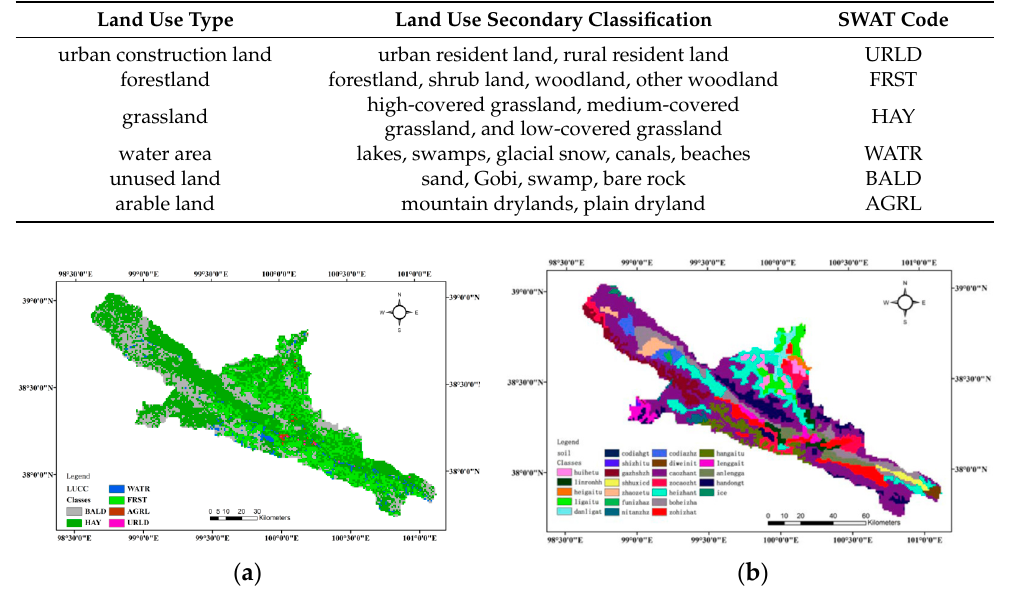
Figure 2. ( a ) Distribution of land use/cover types; ( b ) Distribution of soil types. Table 2. Meteorological station information.